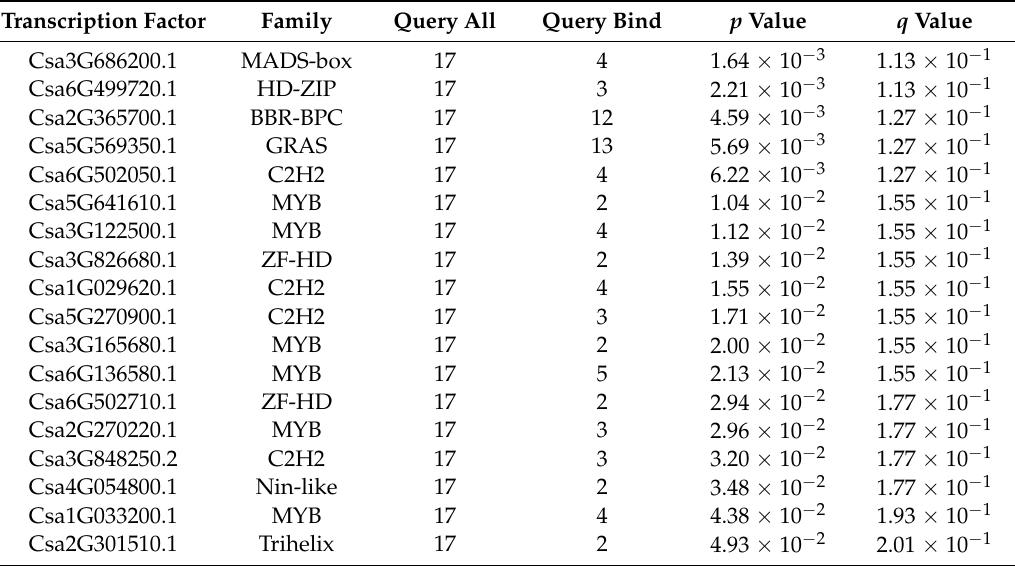
Figure 3. Putative conserved motifs in the promoters of CsGAoxs according to phylogenetic relationship. The 3 motifs were identified online using the MEME with 1.5 kb upstream region of start condon of all CsGAox genes. The following parameters “nmotifs 3, minw 6, maxw 20, minsites 30, maxsites 100” were used in MEME. Different motifs are indicated by different colors and are numbered 1–3. The logos of 3 conserved domain sequences, which were shown on the top right corner, were obtained from MEME Suite website. The bit score shows the information content of each position in the amino acid sequence. Table 1. Candidate transcription factors binding promoters of CsGAoxs identified by